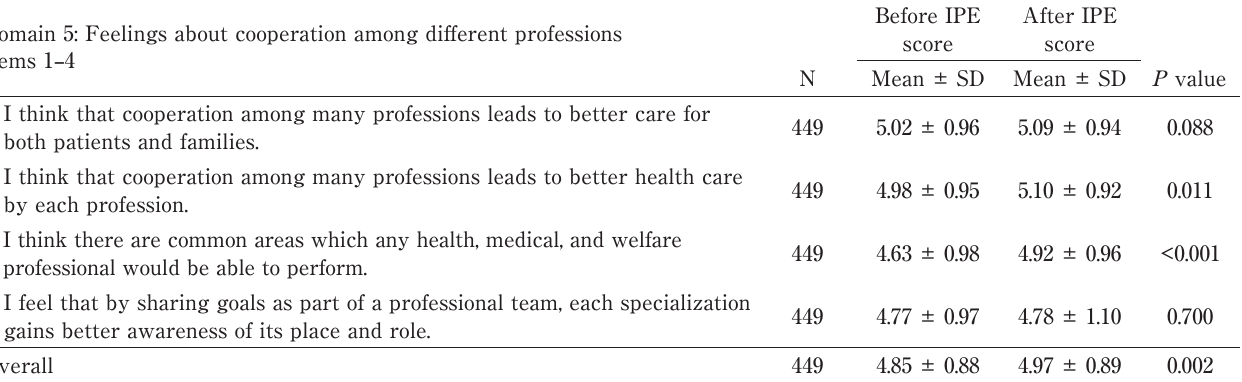
Table 6. Comparison of the scores before and after IPE in domain